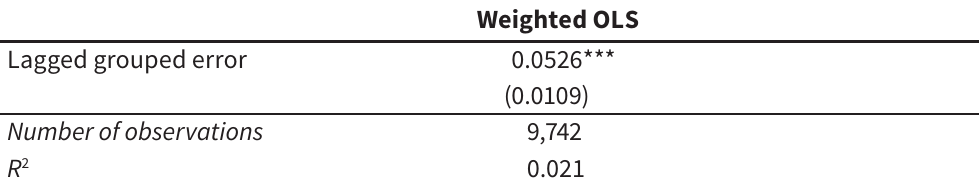
The Breusch–Godfrey LM test on grouped errors